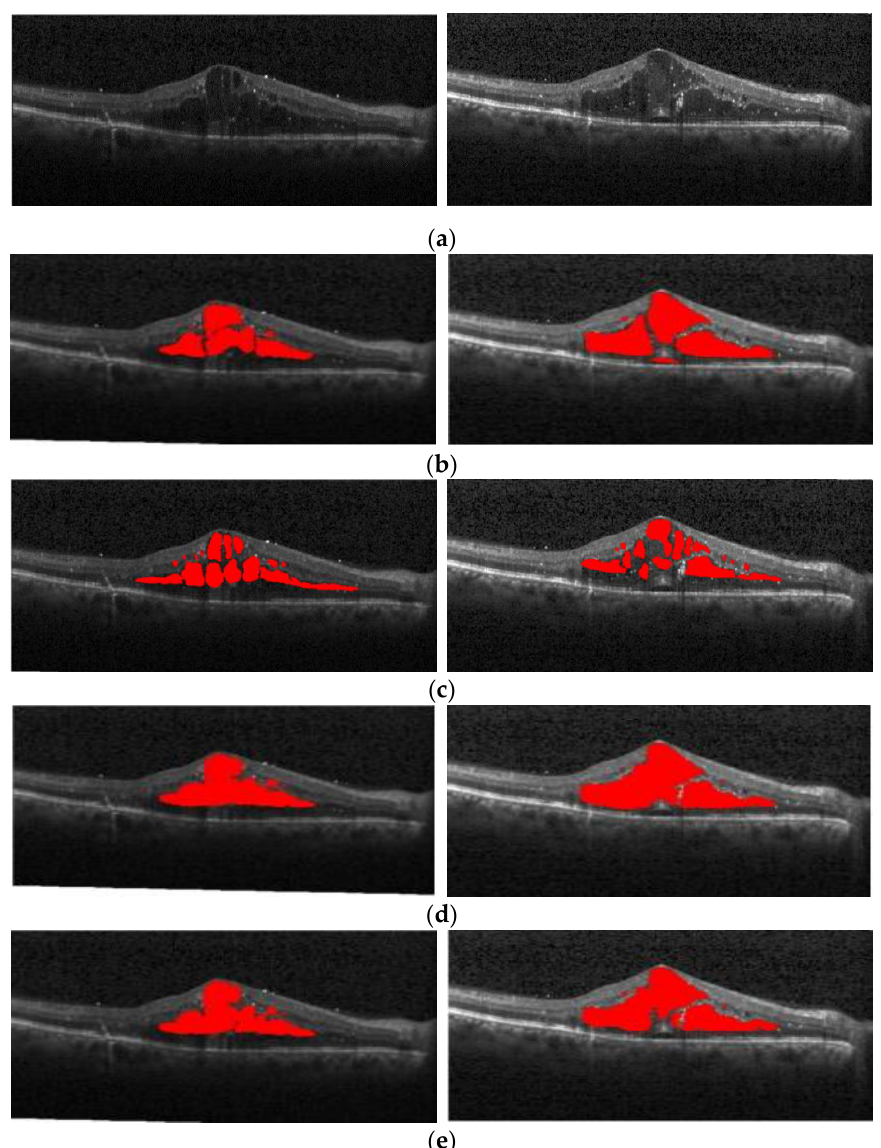
Table 4. Quantitative comparison of segmentation results for diverse edemas in multi-regions.